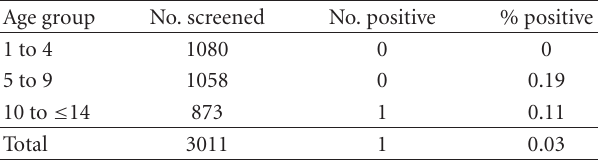
Table 2: Blood spots from children ≤ 14 years of age ( n = 3011) from Wadelai onchocerciasis focus tested for IgG4 antibodies against the OV-16 recombinant antigen in